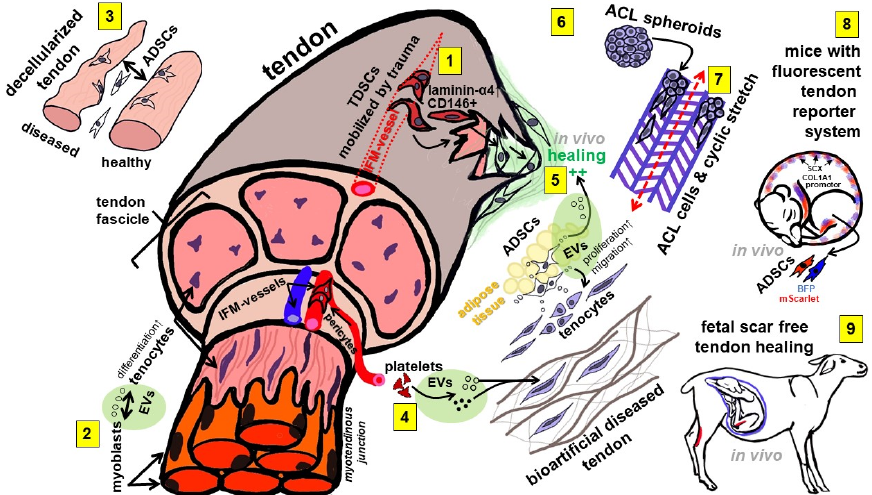
Figure 1. A synopsis of topics investigated in the articles summarized in this Special Issue. 1: CD146+ cells represent an interfascicular stem cell population recruited by laminin- α 4 in tendon injury. 2: Mechanostimulated myoblast-derived EVs induce either tenocyte differentiation or myofibroblast transition. 3: ADSCs respond to the decellularized ECM of diseased and healthy tendons with a